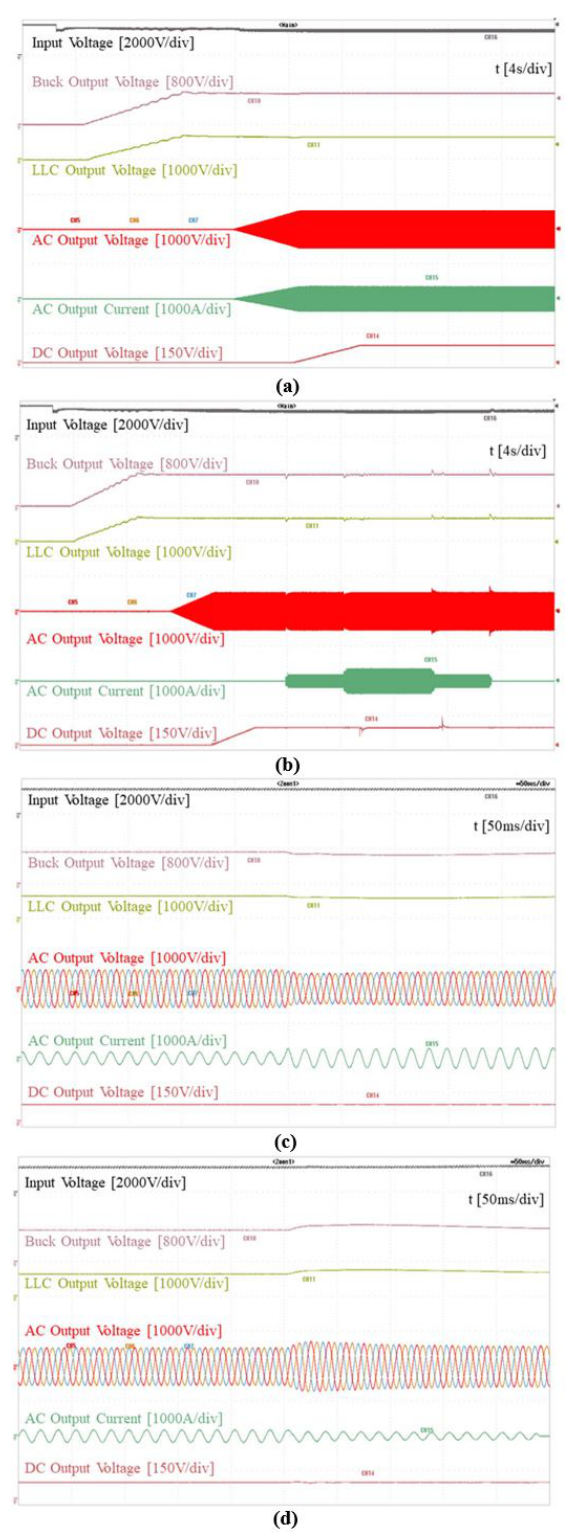
Figure 22. Experimental results of resonant auxiliary power supply for railway